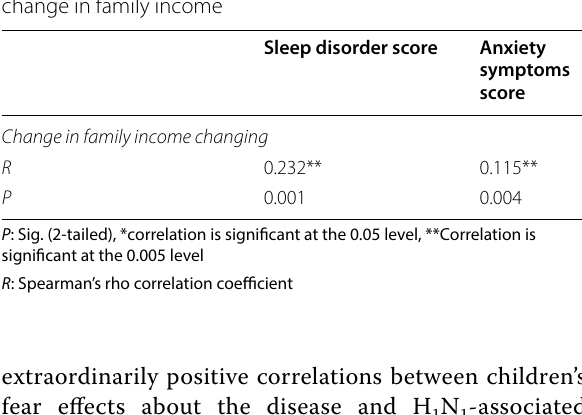
Table 8 Correlation between anxiety, sleep disorder score and change in family income